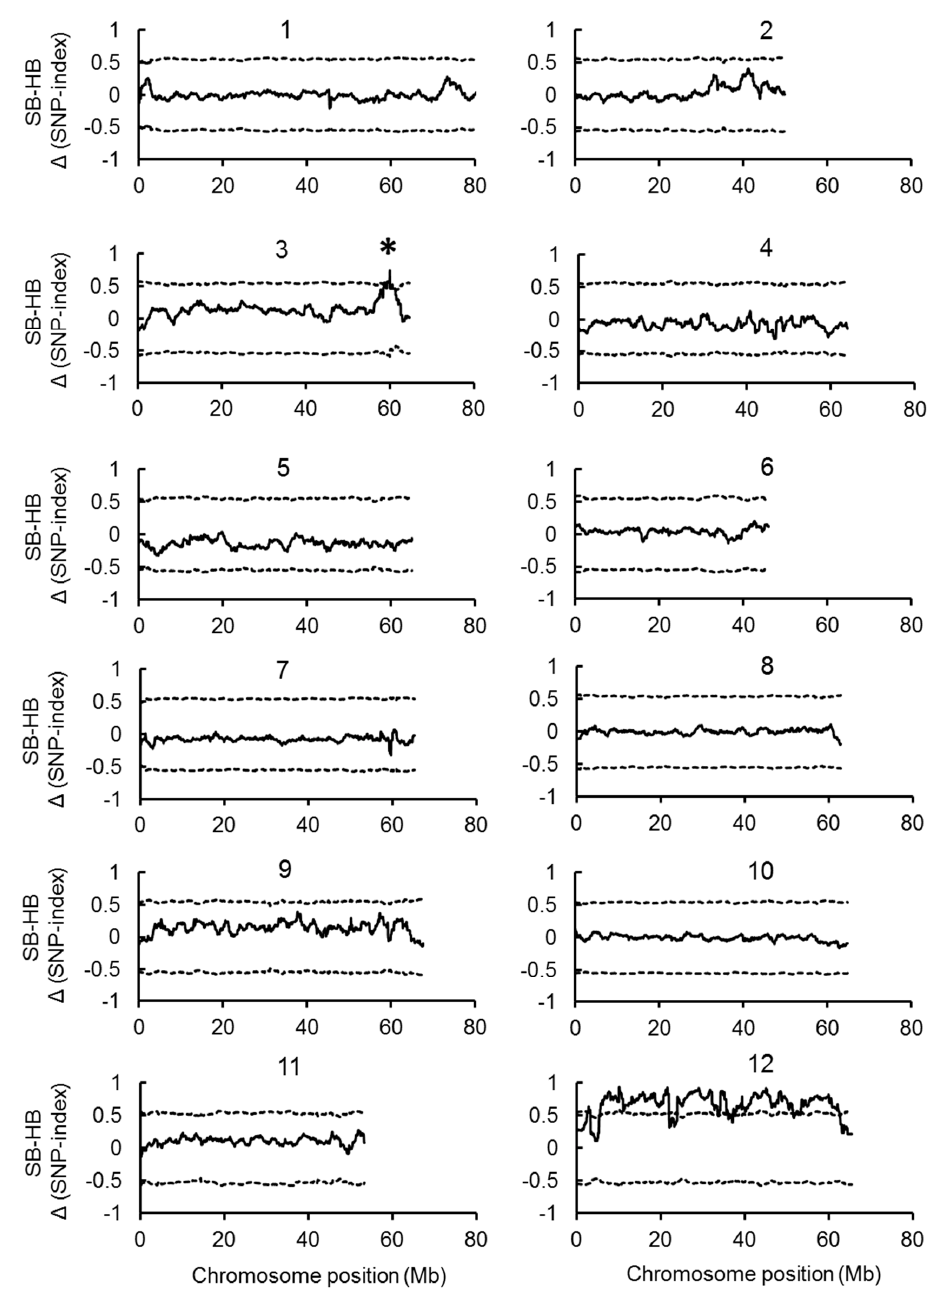
Figure 3. Identification of BN QTLs in tomato chromosome. The ∆ (SNP-index) was calculated as SB’s SNP-index subtracted from HB’s SNP-index. The X-axis denotes the physical positions (Mb) on the tomato chromosomes. The Y-axis represents the ∆ SNP-index, which has been estimated for 2 Mb physical intervals with a 50 kb sliding window. The dotted lines are the threshold value, which are plotted using the statistical confidence intervals under the null hypothesis of no QTL ( p < 0.05)